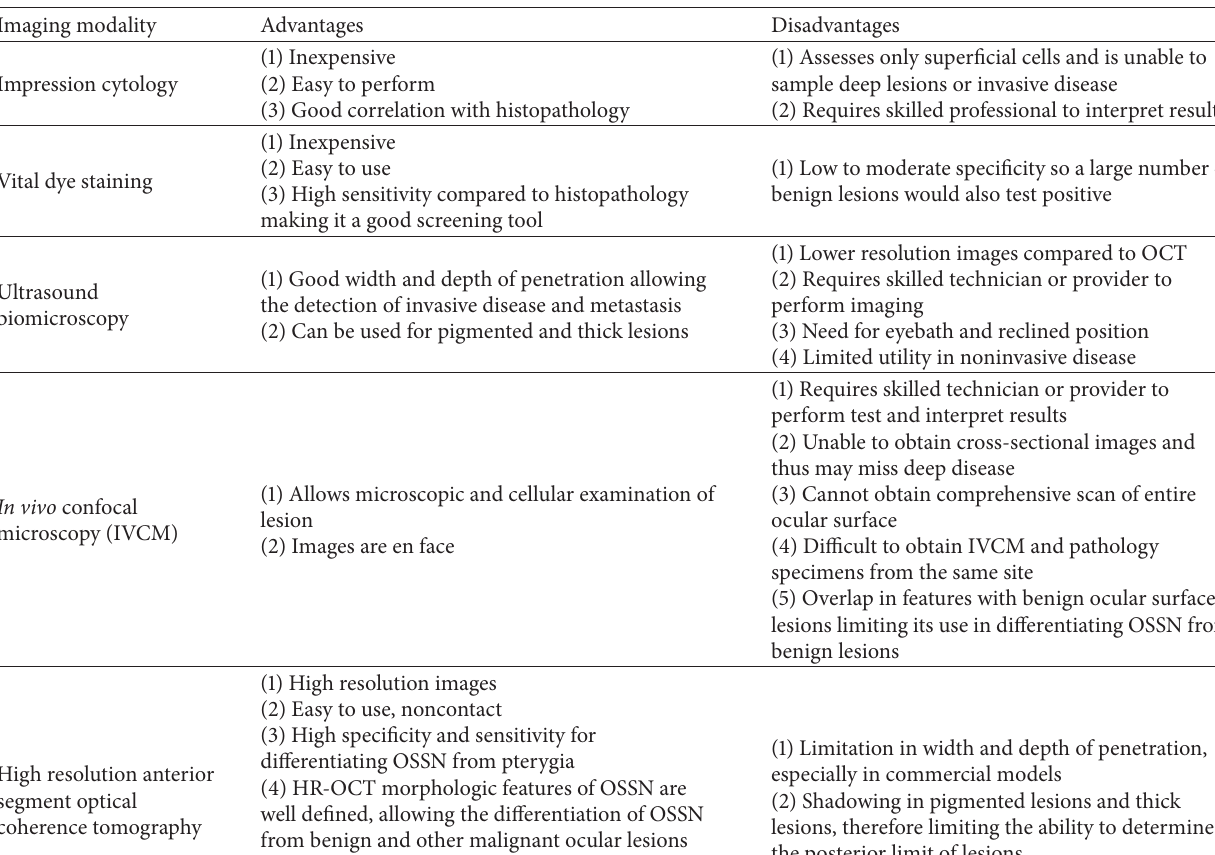
Table 2: Summary of advantages and disadvantages of adjunctive diagnostic modalities in